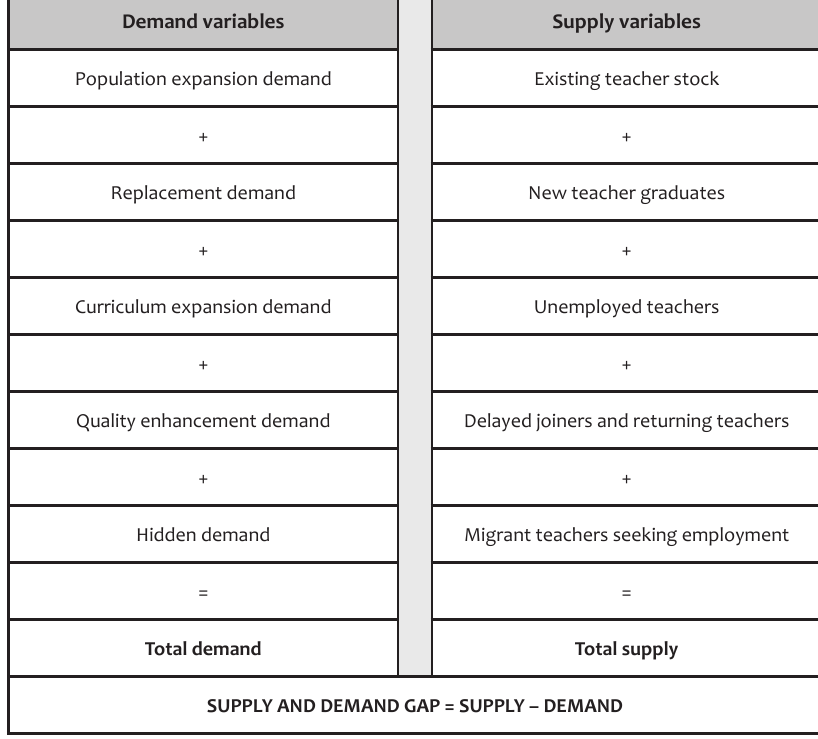
Figure 2: Teacher supply and demand: Conceptual model The model